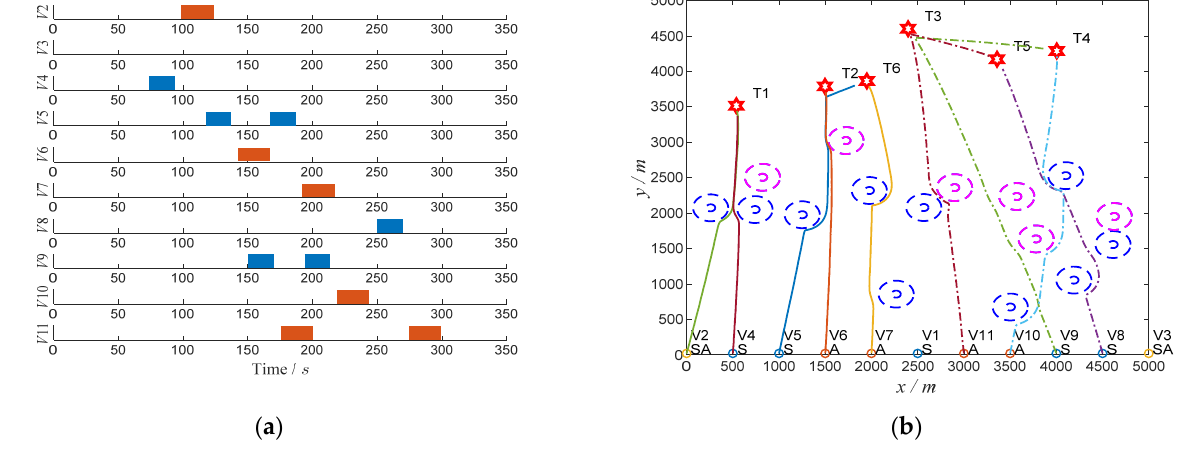
Figure 11. ( a ) The execution sequence of the UAV swarm; ( b ) the diagram of the UAV swarm performing tasks.